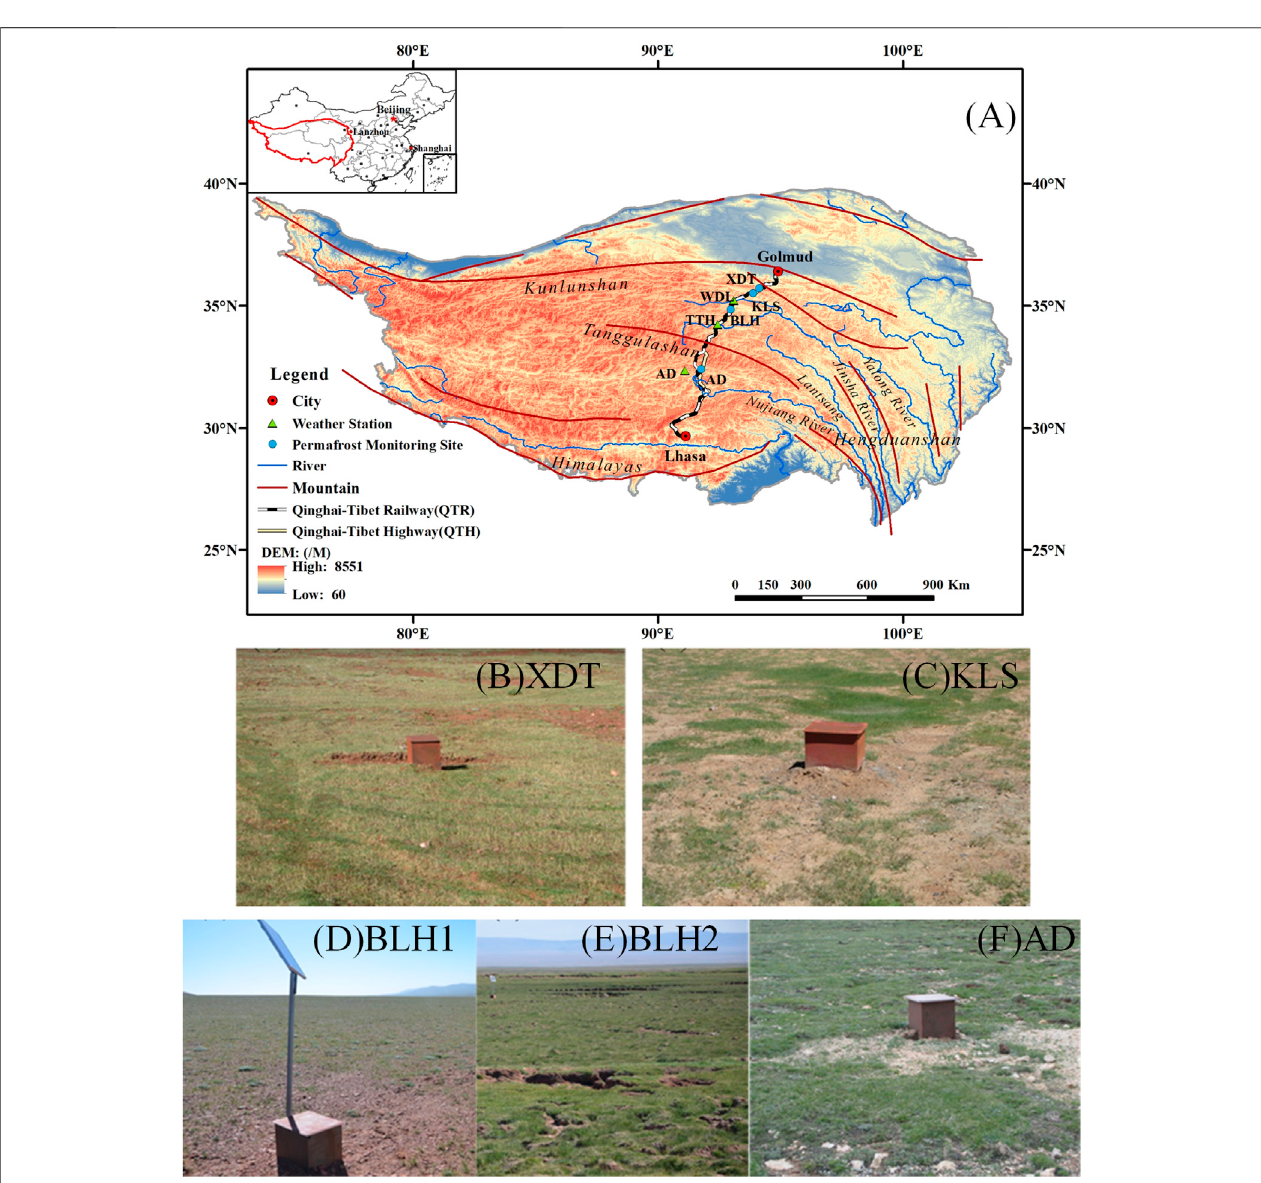
FIGURE1| Locationsofthe fi vepermafrostmonitoringsitesandthreeweatherstationsalongthehighway (A) andthetopographyconditionsatthe fi vepermafrost monitoring sites along the highway (B – F) .